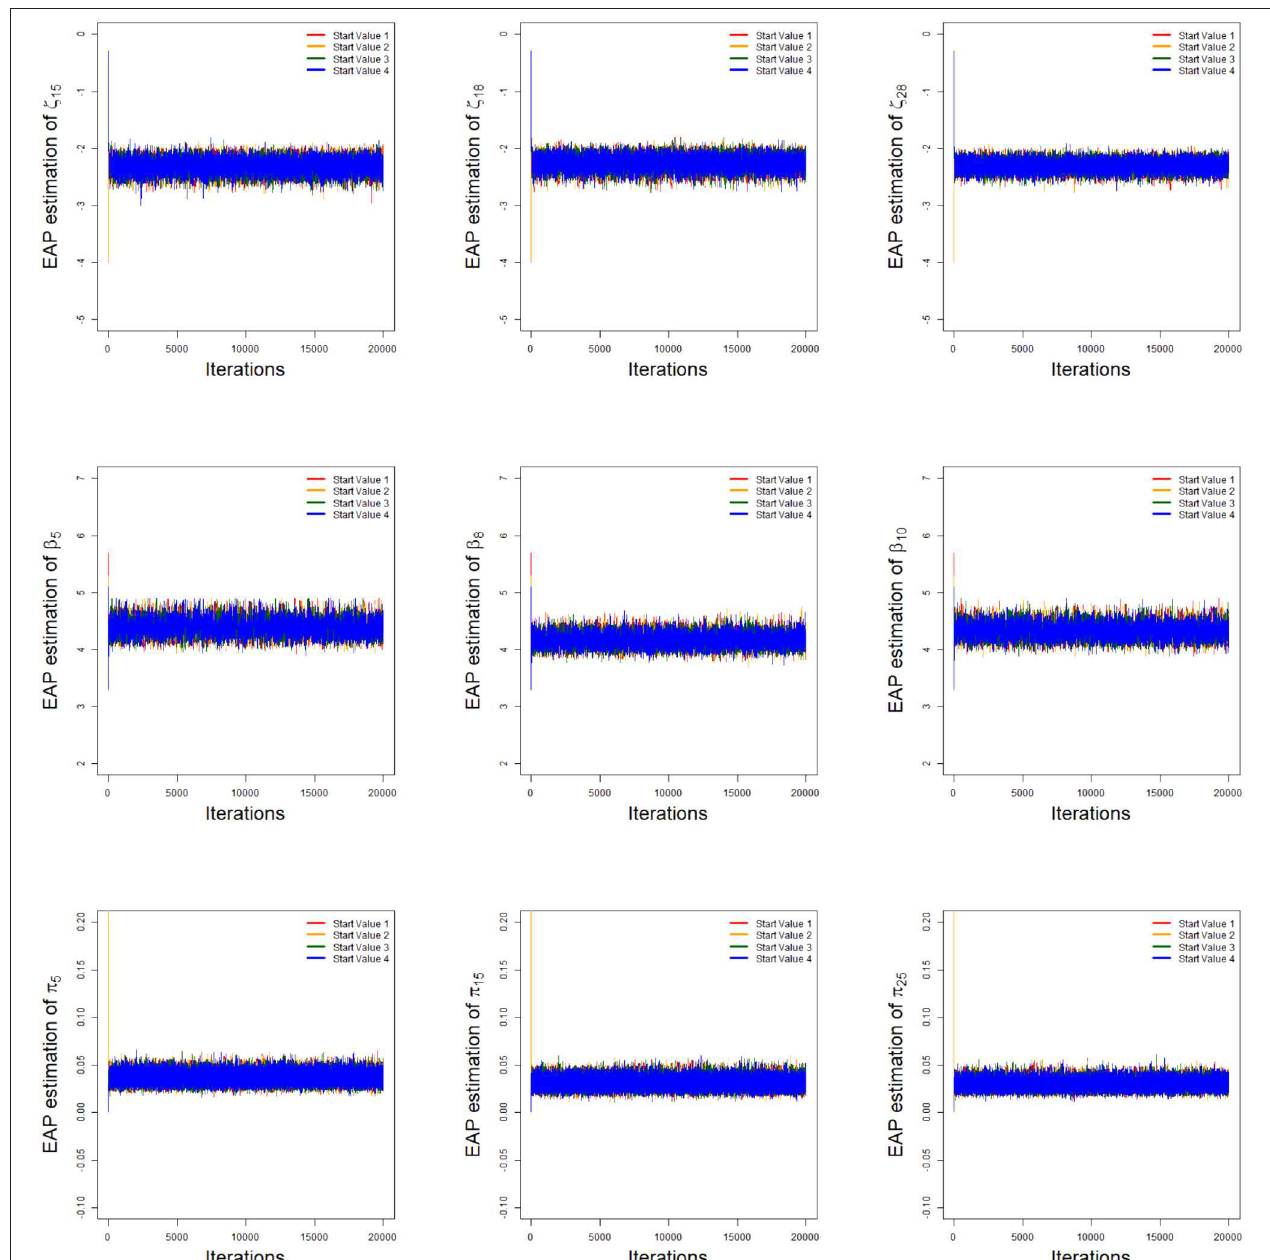
FIGURE 1 | The trace plots of the arbitrarily selected item and class membership probability